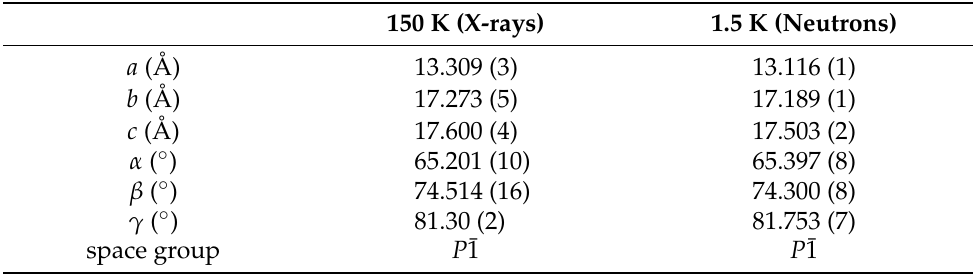
Table 1. The cell parameters obtained with neutrons at 1.5 K compared with those previously obtained at 150 K with X-rays